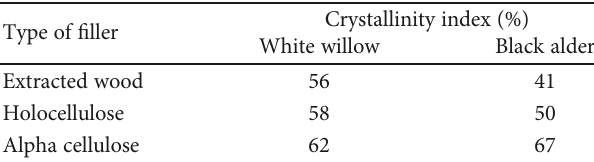
Figure 2: TG-DTG curves of extracted wood fl our (white willow). Table 3: Crystallinity indices of fi